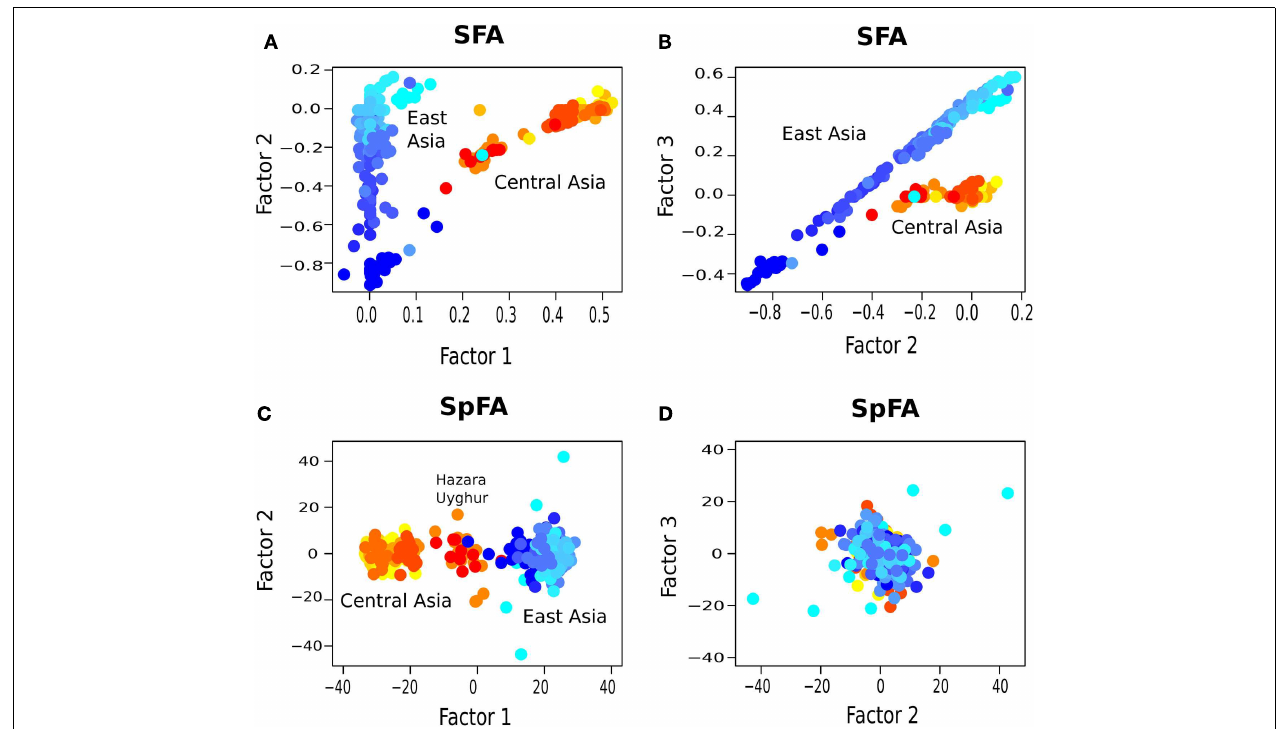
FIGURE 8 | Factor plots for (A,B) SFA and (C,D) spFA with K = 3